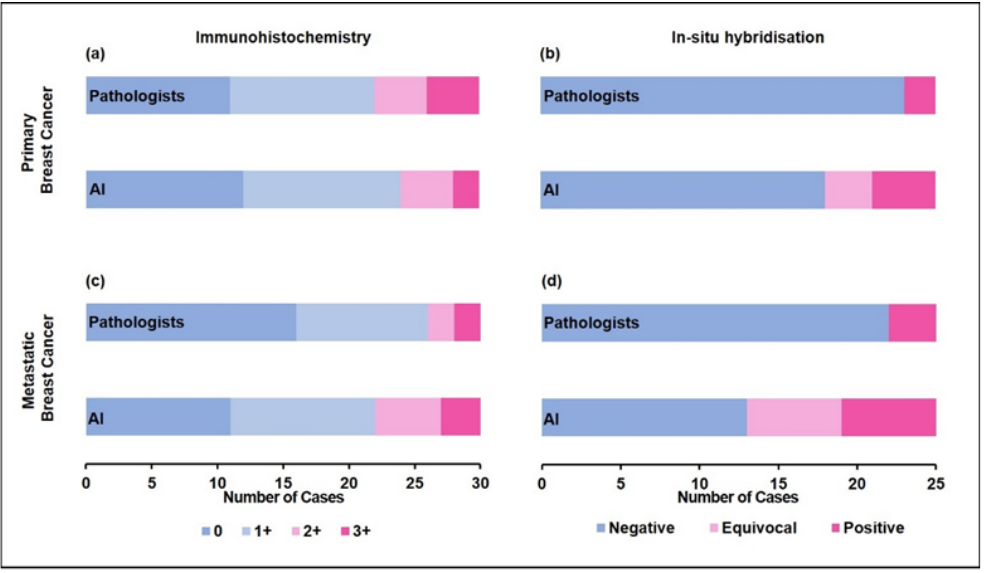
Figure 5. Primary breast cancer ( a ) IHC scores and ( b ) ISH status, and matched metastatic breast cancer ( c ) IHC scores and ( d ) ISH status assessed by the Pathologists versus AI. Equivocal ISH scores refer to groups 2, 3, and 4 in the 2018 ASCO/CAP guidelines.